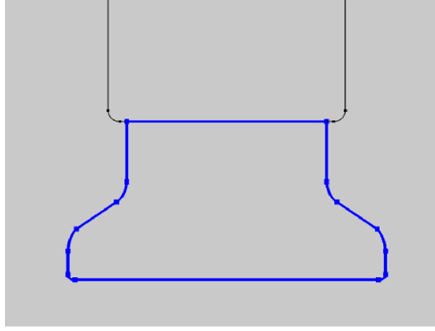
Figure 9. Terminal voltage of 20 kV on insulator model.